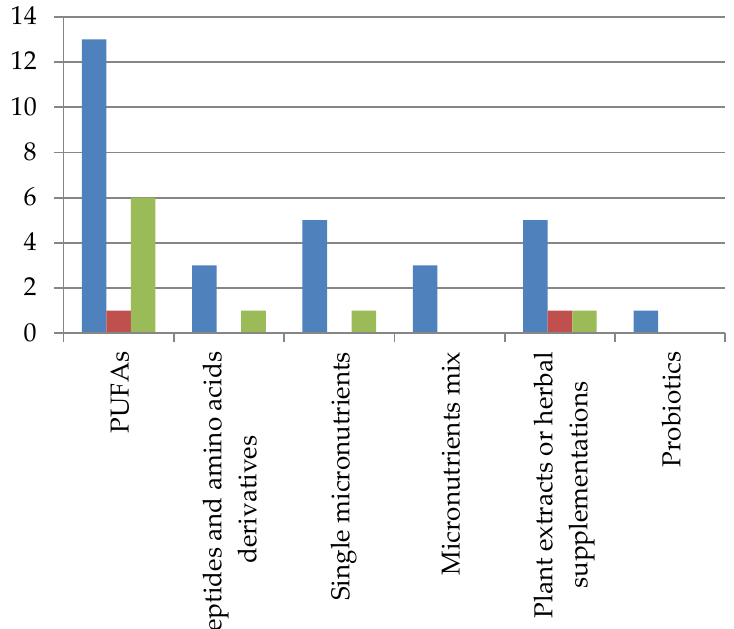
Figure 2. E ff ect of supplementations in ADHD